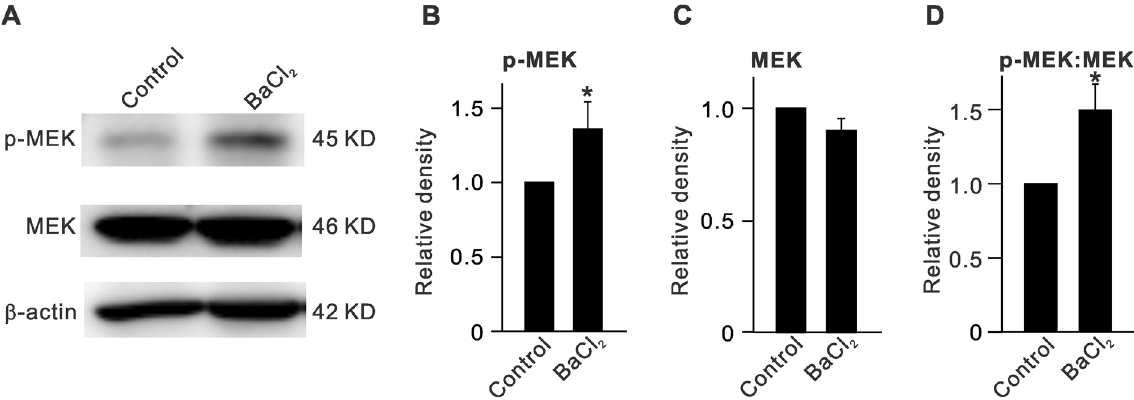
Figure 3. Elevation of p-MEK expression in BaCl 2 -injected retinas. ( A ) Representative immunoblots showing changes in p-MEK and MEK expressions in retinas with vehicle (Control)- or BaCl 2 -injection. ( B , C ) Bar charts summarizing the average densitometric quantification of immunoreactive bands of p-MEK ( B ) and MEK ( C ) protein expression as shown in ( A ). ( D ) Bar charts summarizing the average p-MEK:MEK ratio. n = 6 all groups. * P < 0.05 vs .